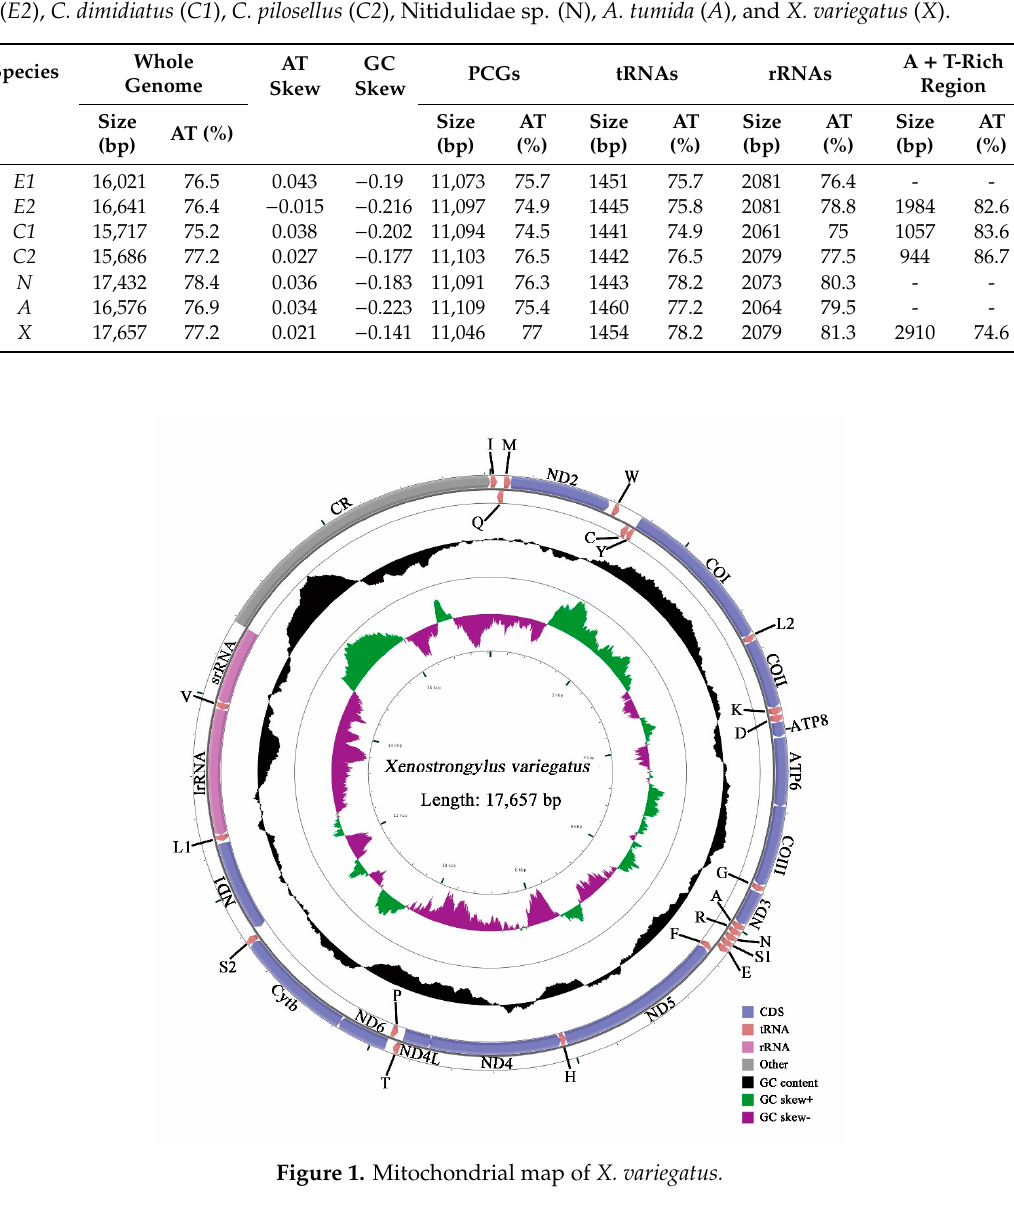
Table 3. Nucleotide composition of the Nitidulidae mitochondrial genomes: E. guttata ( E1 ), Epuraea sp.